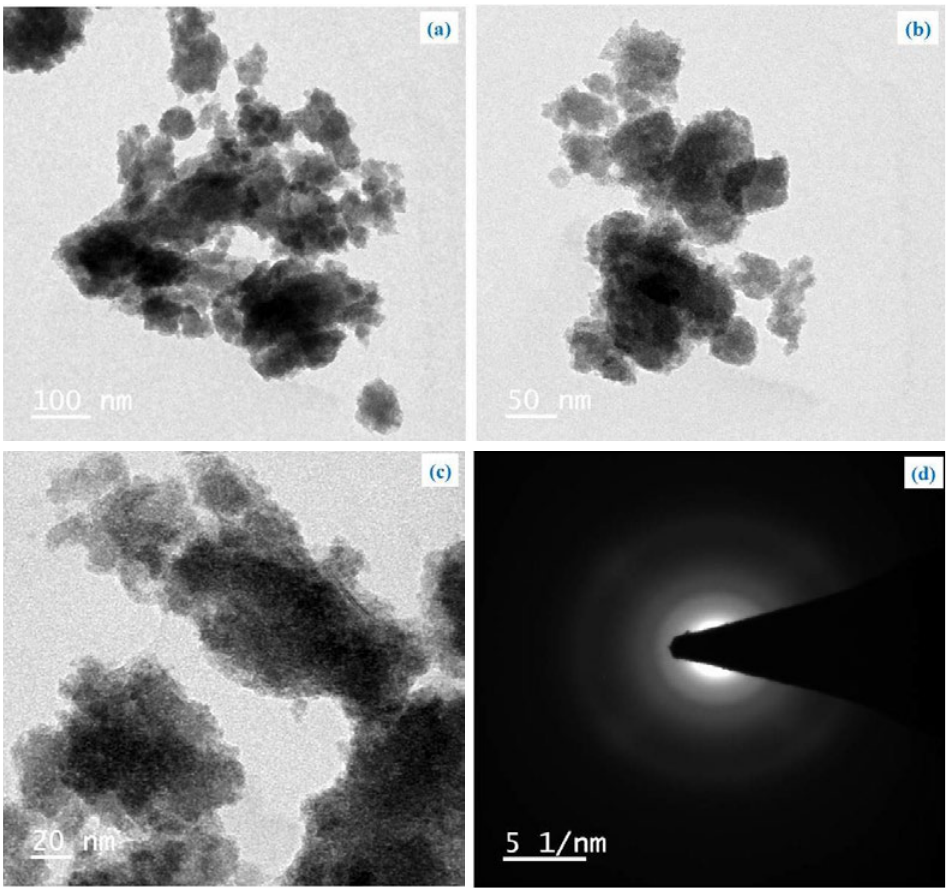
Fig. 6. (a-c) TEM images of ZrO